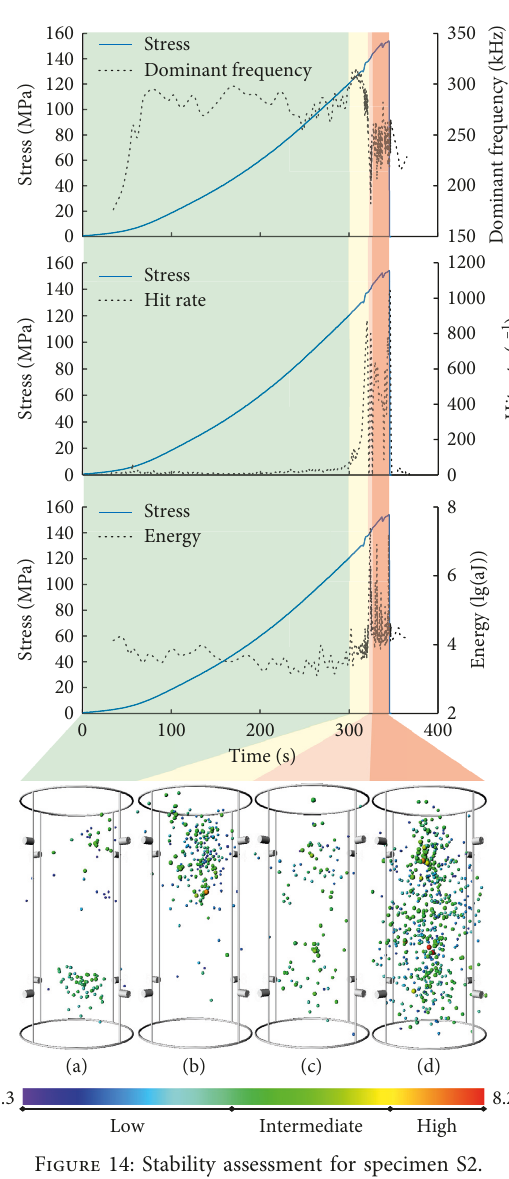
Figure 14: Stability assessment for specimen